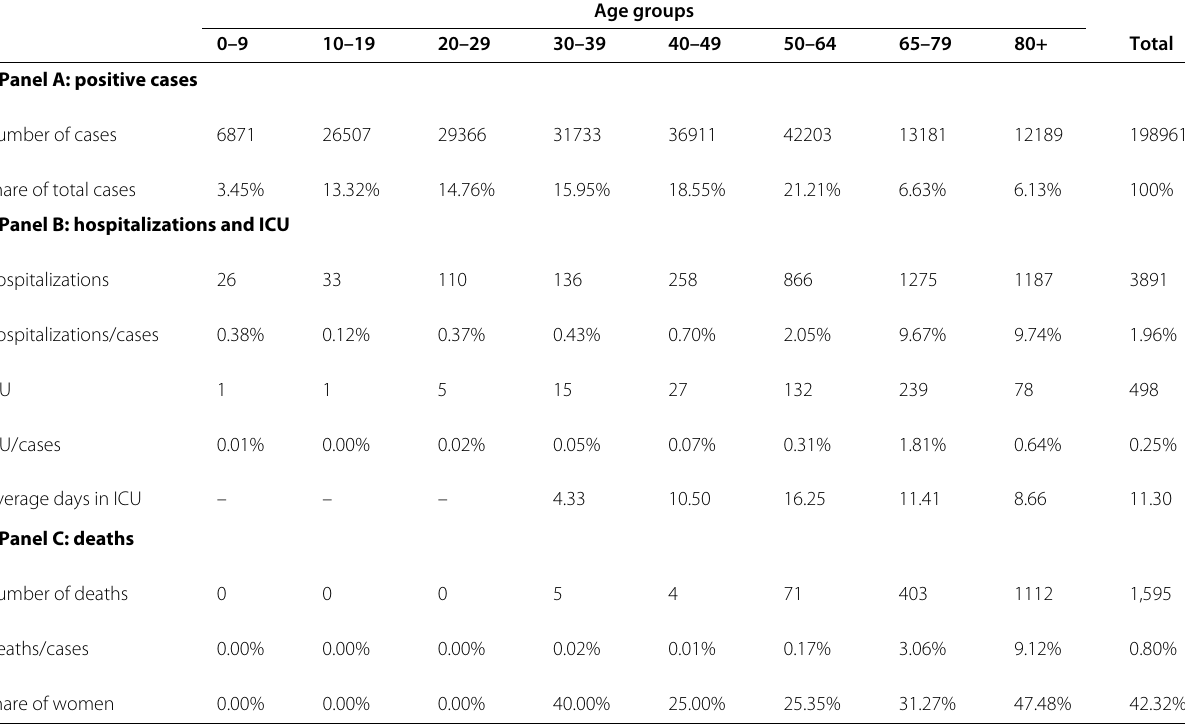
Table 3 Descriptive statistics by age group after adjusting the data (by May